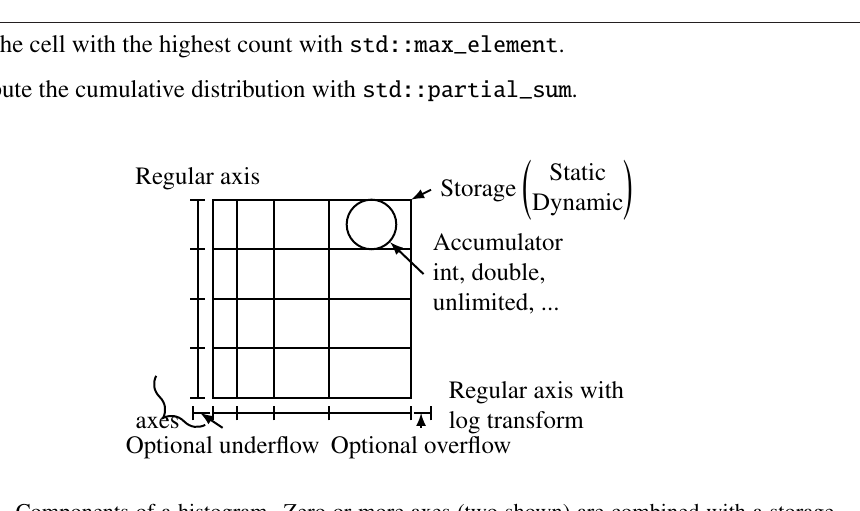
Figure 1. Components of a histogram. Zero or more axes (two shown) are combined with a storage. Each item stores an